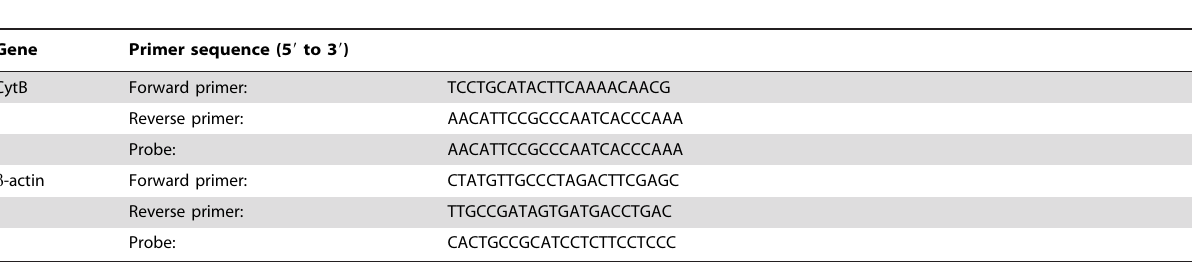
Table 1. mitochondrial DNA